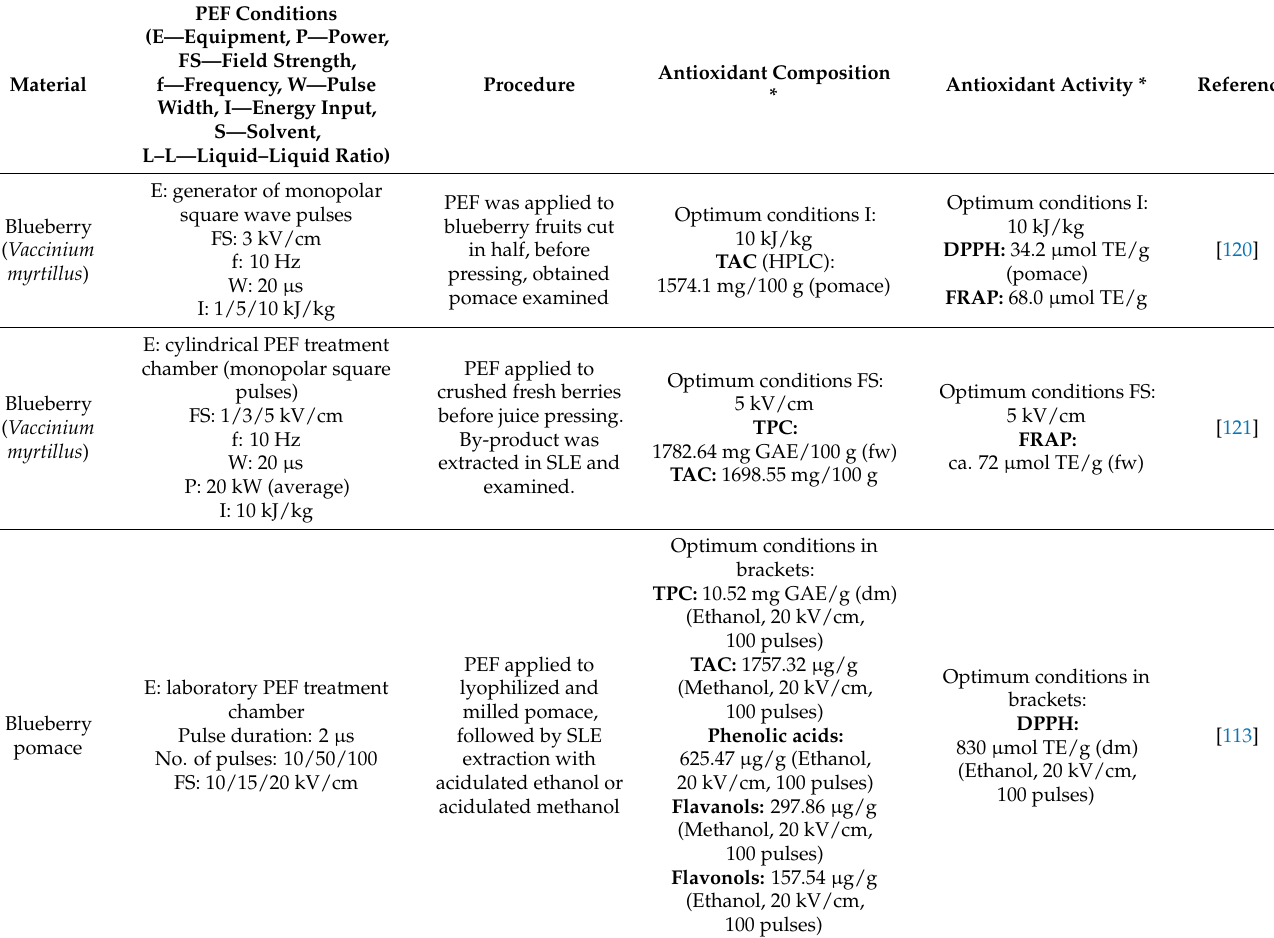
Table 7. Conditions and results of pulsed electric field-assisted extraction of bioactive compounds from berry